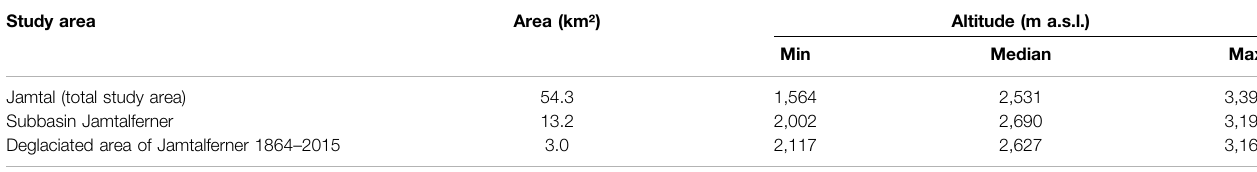
TABLE 1 | Areal extents and altitudes of the three study areas analysed in the present study (compare Figure 1 ).